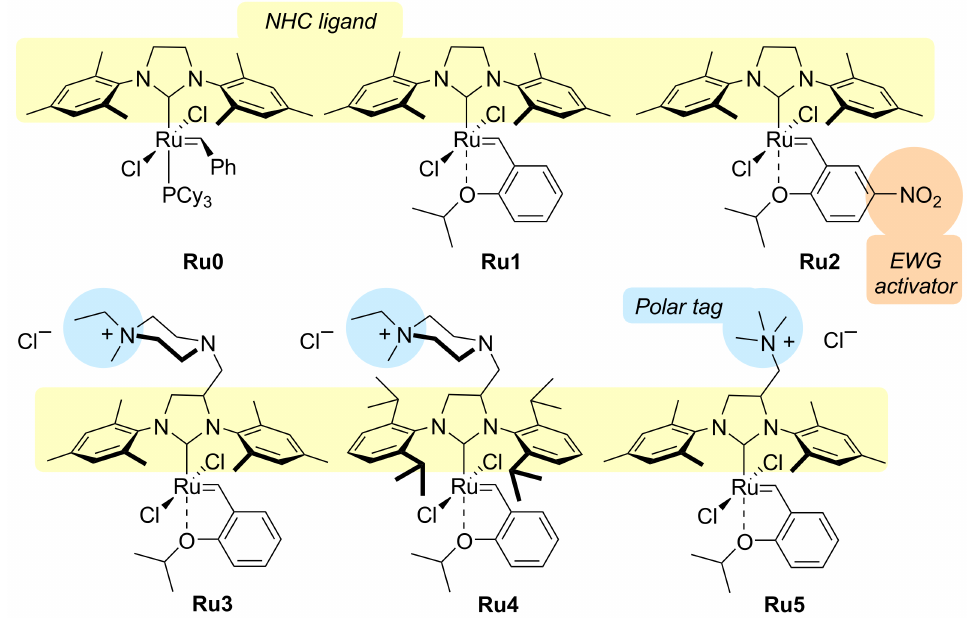
Figure 1. Selected ruthenium olefin metathesis catalysts. Cy =